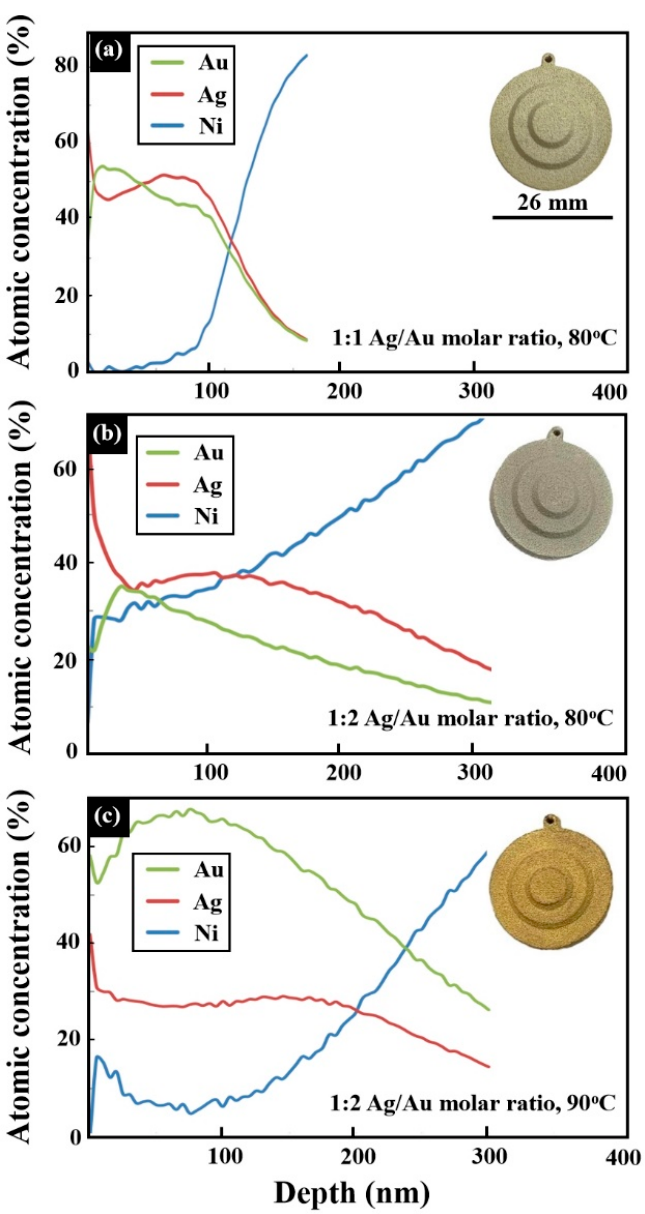
Figure 17. XPS elemental analysis profiles of the Au–Ag film coated on the disk-shaped specimen: ( a ) deposition made with 1:1 Ag/Au molar ratio in solution at 80 °C; ( b ) deposition made with 1:2 Ag/Au molar ratio in solution at 80 °C; and ( c ) deposition made with 1:2 Ag/Au molar ratio in solution at 90 °C.